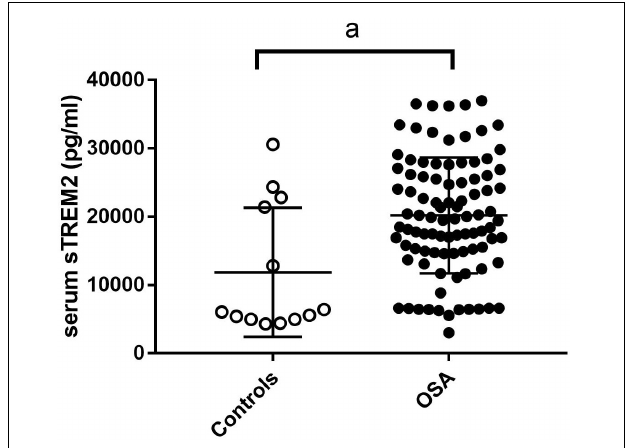
FIGURE 2 | The sTREM2 level in control group and OSA group. The comparison was evaluated by covariance analysis; a, compared with